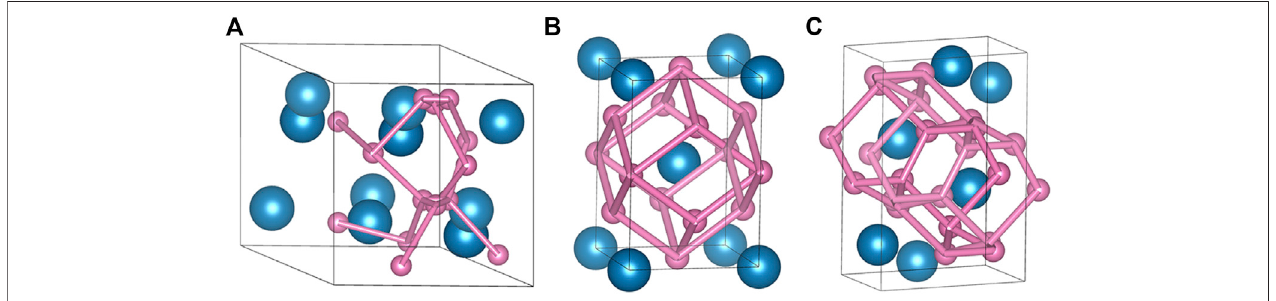
FIGURE1| Theunit cell ofYH 3 crystalsunder different pressures. (A) YH 3 at 0 GPa, (B) YH 3 at 50 GPa, (C) YH 3 at 300 GPa. Thepink ballisH, and the blue ballis rare earth yttrium (Y).